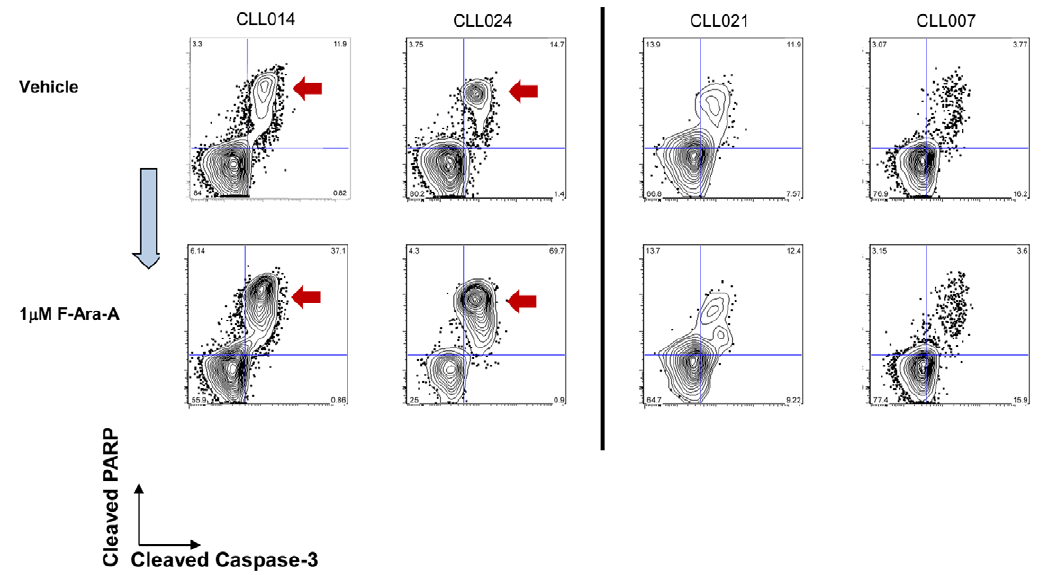
Figure 3. Effect on apoptosis of Invitro exposure of CLL B cells to F-ara-A. Representative 2D flow plots (cleaved caspase 3 (X-axis) and cleaved PARP (Y-axis)) show that samples CLL014 and CLL024 undergo F-ara-A-mediated apoptosis (left-hand panels, (red arrows). By contrast samples CLL021 and CLL007 were relatively refractory to F-ara-A treatment (right-hand panels).